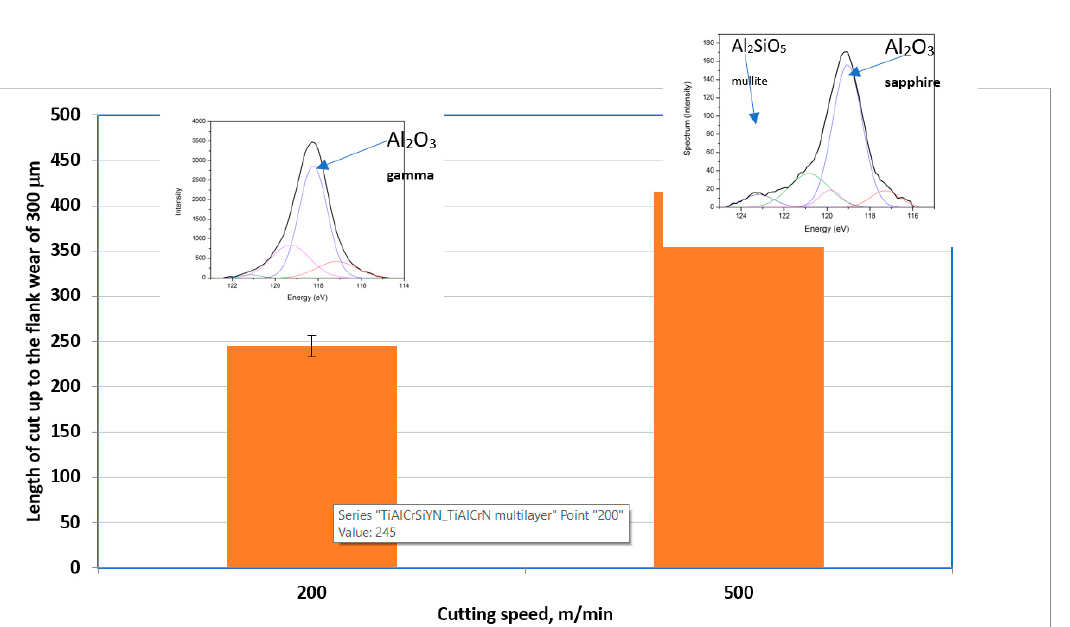
Figure 8. Improvement in wear performance with severity of tribological conditions in relation to the tribo-films formation on the friction surface [75].